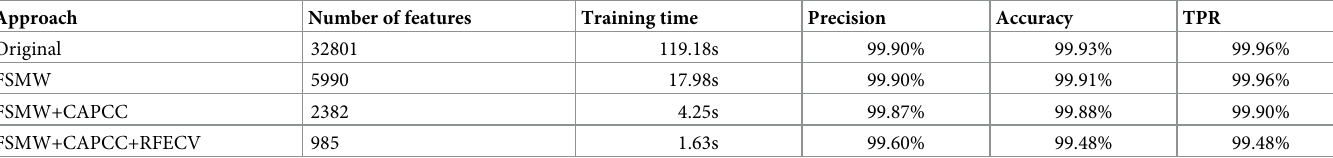
Table 13. The influence of three levels of feature selection methods on the effect of feature set.